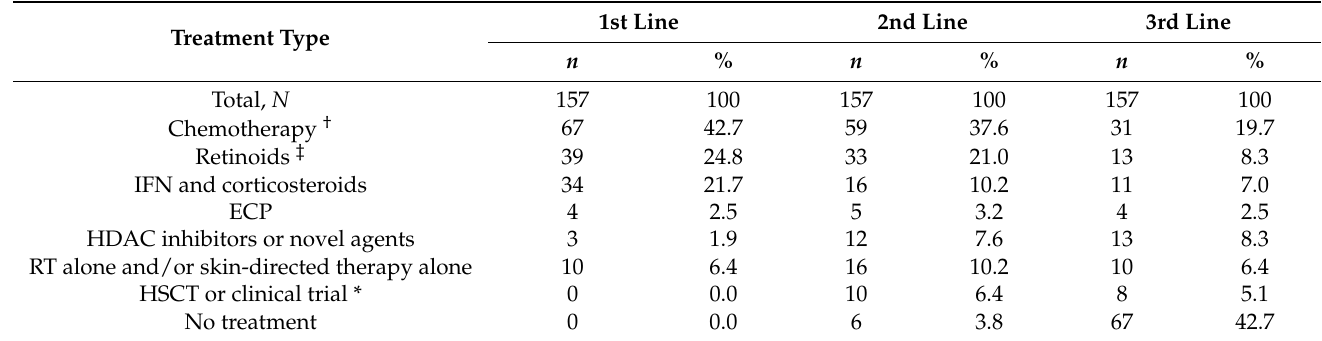
Table 6. Treatment pattern across the 3 lines of